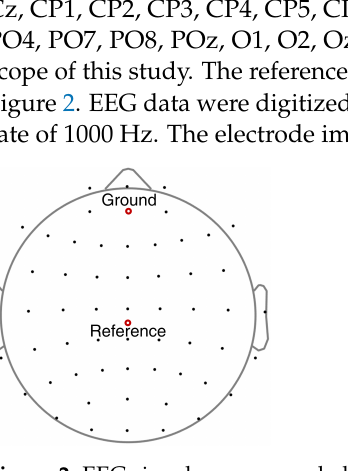
Figure 2. EEG signals were recorded according to the international 10–20